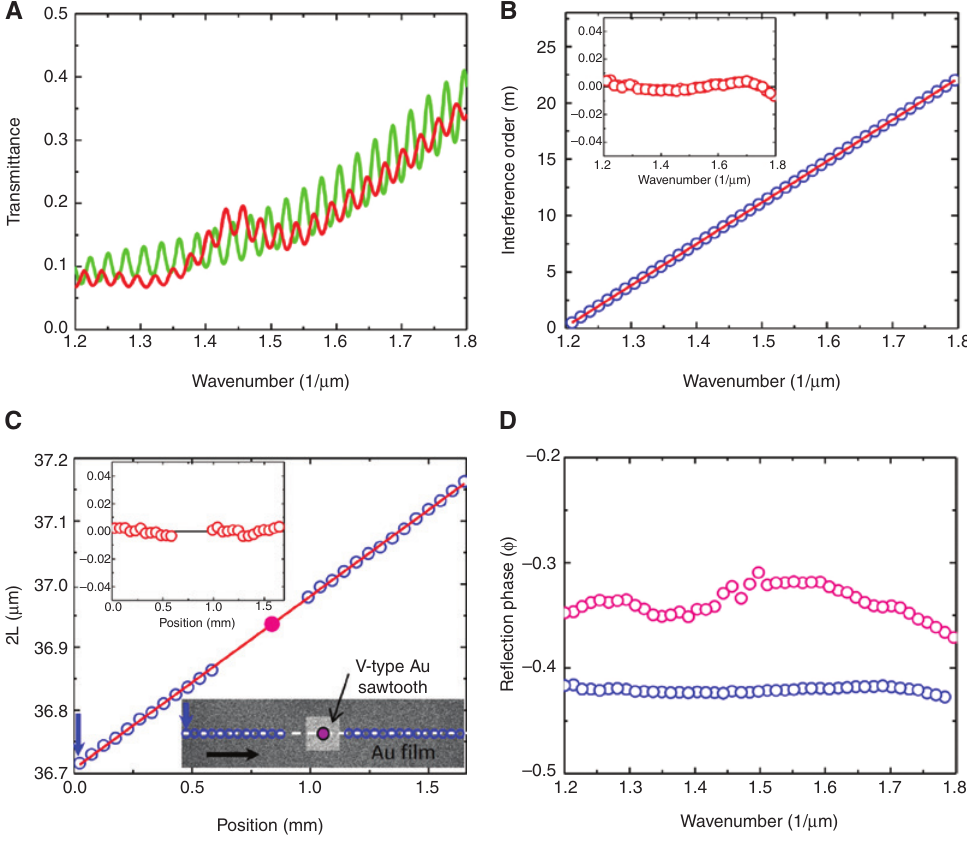
Figure 3: Reflection phase measurement. (A) FP transmission of RCP incidence light for Au film (green curve) and V -type Au sawtooth metasurface (red curve). (B) Interference order m vs the corresponding 1/ λ for the Au film in (A). Open blue circles are the data and the solid red line is a fit to the data using Eq. (1). The m inset shows the residual of the fit. (C) The slope (2 L ) obtained from the m vs. 1/ λ fit for Au film taken at different positions (open blue m circles) along a path (white dashed line in the lower-right SEM image inset) crossing over the V -type Au sawtooth metasurface. The blue arrow indicates the first position of the Au film where data was taken for the reflectance shown in (A). The red line is a linear fit to the data. The upper-left inset is the residual of the fit. The solid pink dot is the interpolated air-gap at the V -type sawtooth metasurface. The lower- right inset shows a SEM image of the V -type Au sawtooth metasurface (light grey 200 × 200 μ m 2 square) and the Au film (dark grey). The open circles are positions where measurements were carried out with the first position indicated by the blue arrow. The horizontal black arrow indicates the direction of measurements. (D) Open blue and pink circles are the reflection phase of RCP incidence for the Au film at the position indicated by the blue arrow shown in (C) and the V -shaped Au sawtooth metasurface,